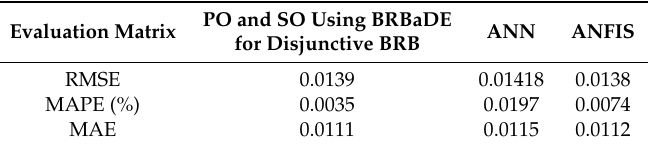
Table 13. Comparison of root mean square error (RMSE), mean absolute percentage error (MAPE), and mean absolute error (MAE) for Disjunctive BRB using PO and SO using BRBaDE, ANN, and ANFIS of testing datasets from Measuring Data Centre Efficiency